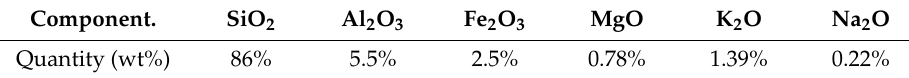
Table 1. Chemical composition of diatomite